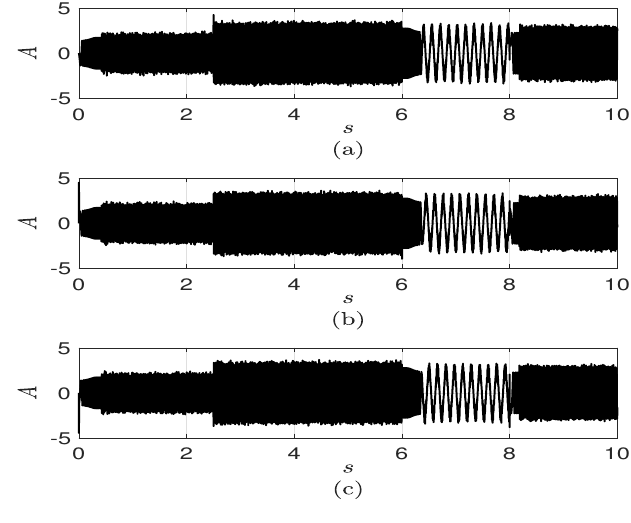
Figure 12. ( a ) Stator currents i a ; ( b ) Stator current i b ; ( c ) Stator Current i c